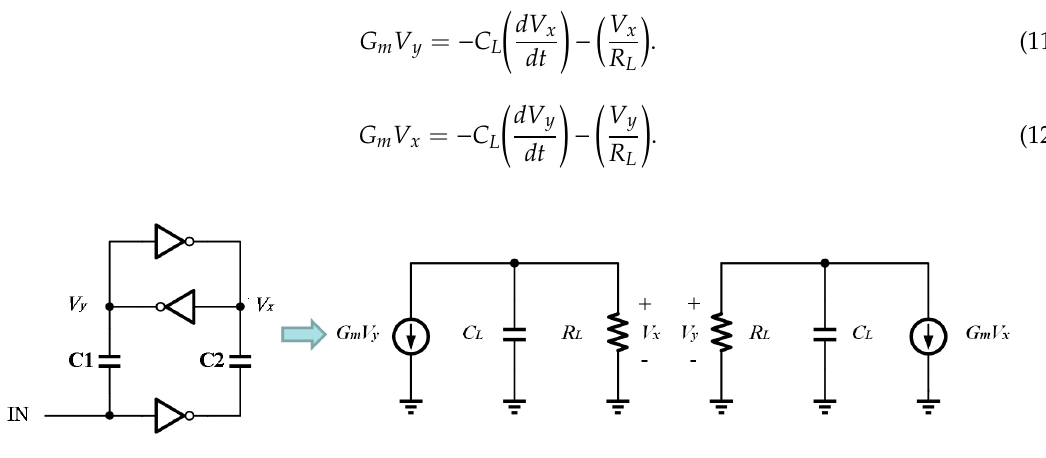
Figure 11. Schematic of a latch-based capacitor-coupled floating level-shifter.